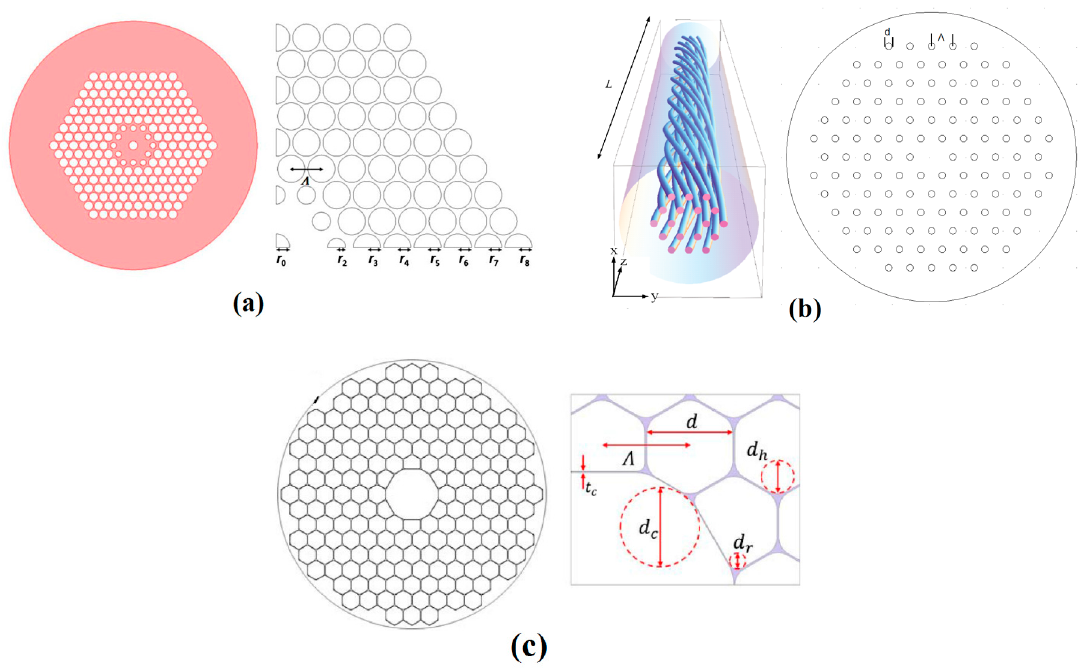
Figure 1. Cross section and structure parameters of ( a ) ring photonic crystal fiber (PCF) (reprinted with permission from [30]. Copyright 2012 Optical Society of America), ( b ) the twisted air-core PCF (Reprinted from [31] by permission from AAAS), and (c) hollow-core photonic bandgap fiber (HC-PBGF) (reprinted with permission from [41]. Copyright 2016 Optical Society of America).